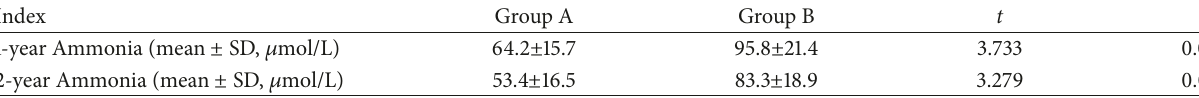
Table 4: Postoperative average ammonia levels stratified by groups.